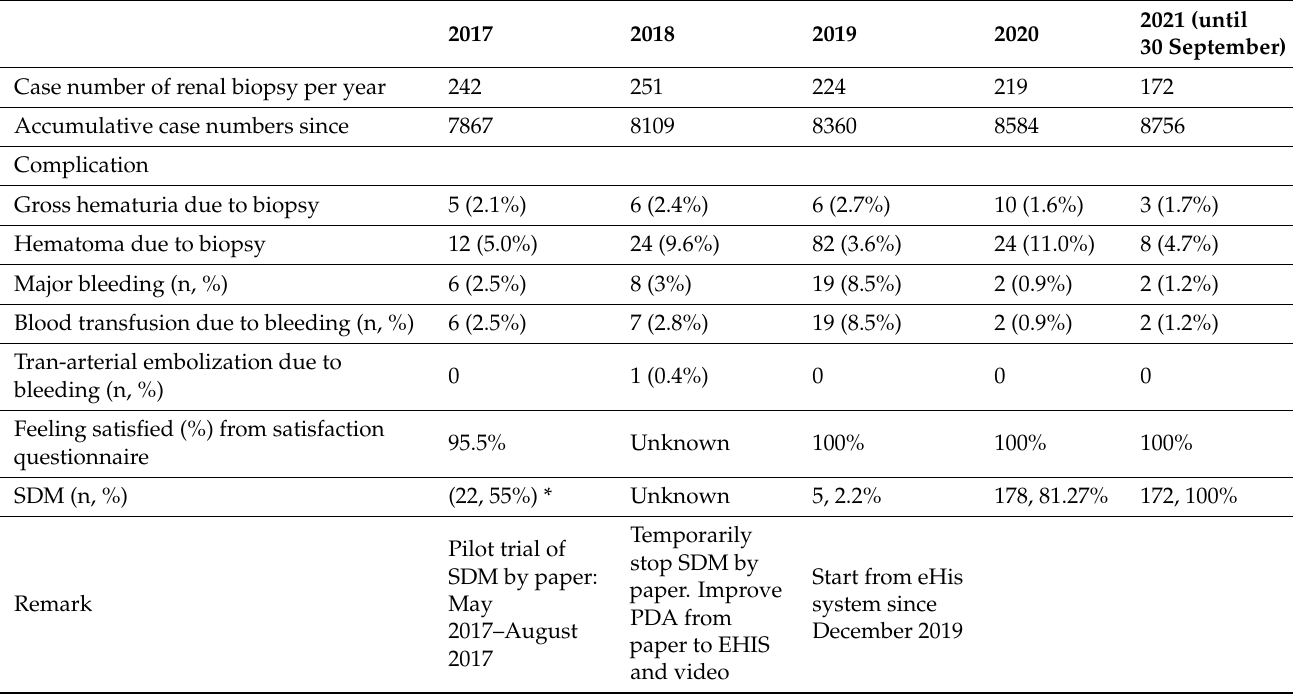
Table 1. Case numbers of renal biopsy and shared decision making and timing according to time